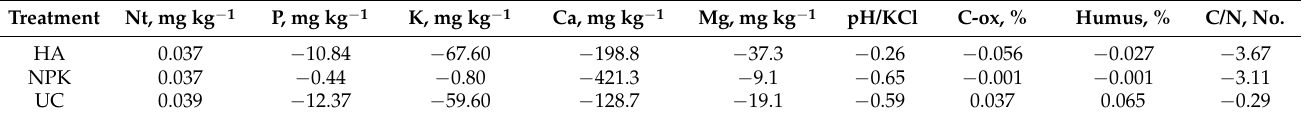
Table 8. The changing status (final minus initial state, 2022 vs. 2017) of the content of nutrients in the topsoil (0–30